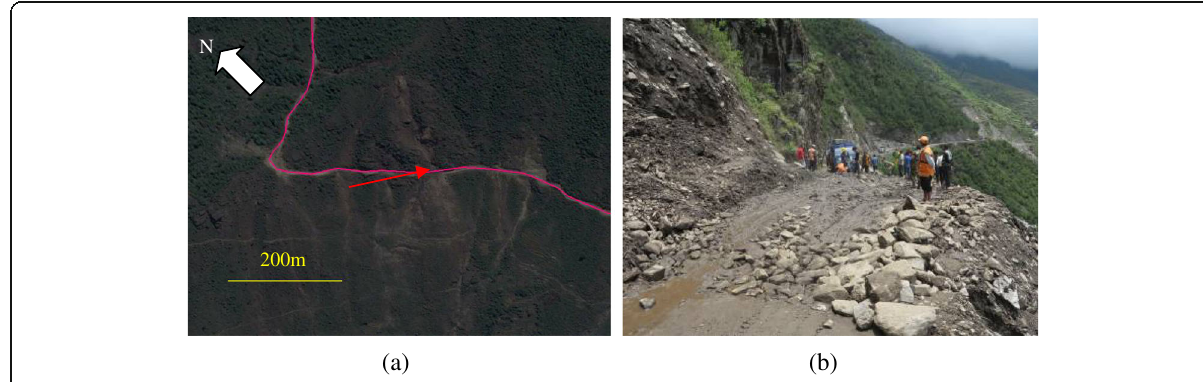
Fig. 5 A series of shallow, disrupted landslides blocking the Pasang Lhamu Highway. a Satellite image of 3 May 2015. b Field photo of 15 June 2015 (by Chong Xu, view to southeast) showing the road was blocked by a secondary landslide caused by a heavy rainfall. The red solid arrow in ( a ) shows the location of field photo in ( b )